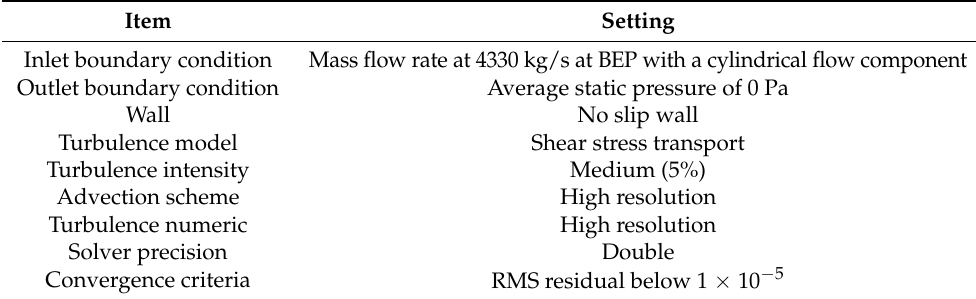
Table 1. Numerical settings for the simulation. Item